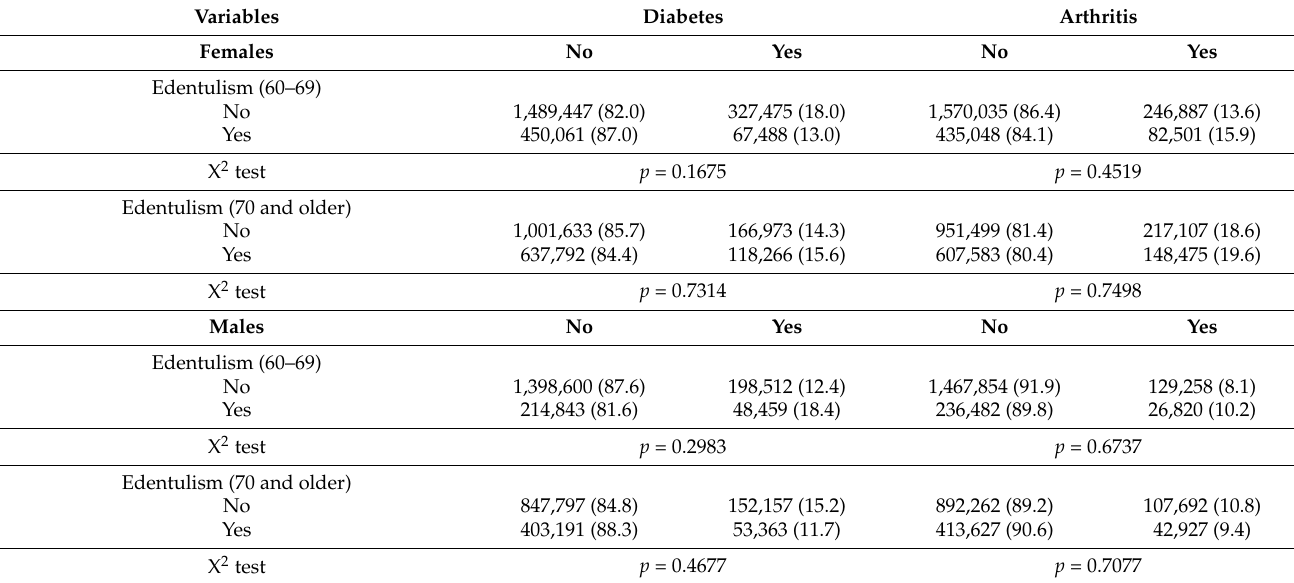
Table 3. Distribution of edentulism due to diabetes and arthritis stratified by age group and sex (estimated population N =